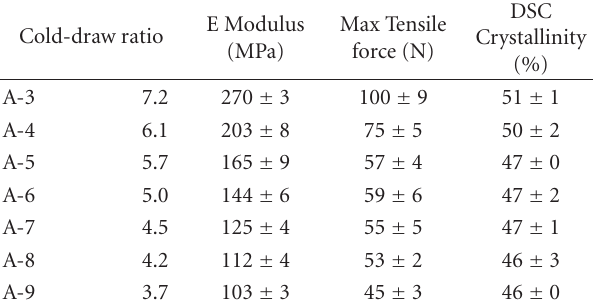
Figure 1: Engineering stress-strain curves of the LLDE monofila- ments at room temperature. Table 2: Classical tensile properties (Elastic Modulus and Maxi- mum Tensile force) and crystallinity by DSC of the oriented LLDPE